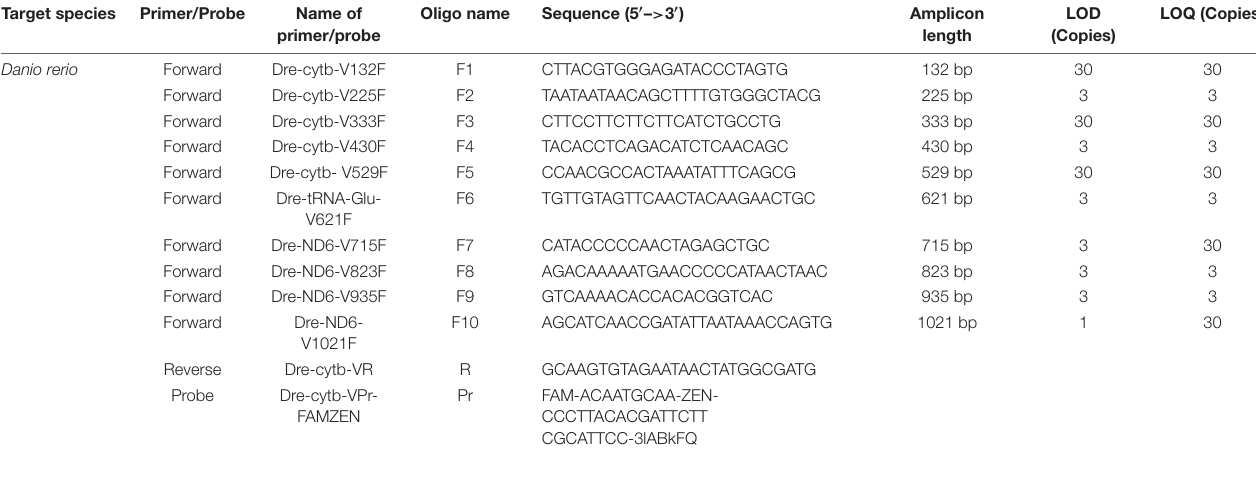
TABLE 1 | Sequences of primers and a probe used in this